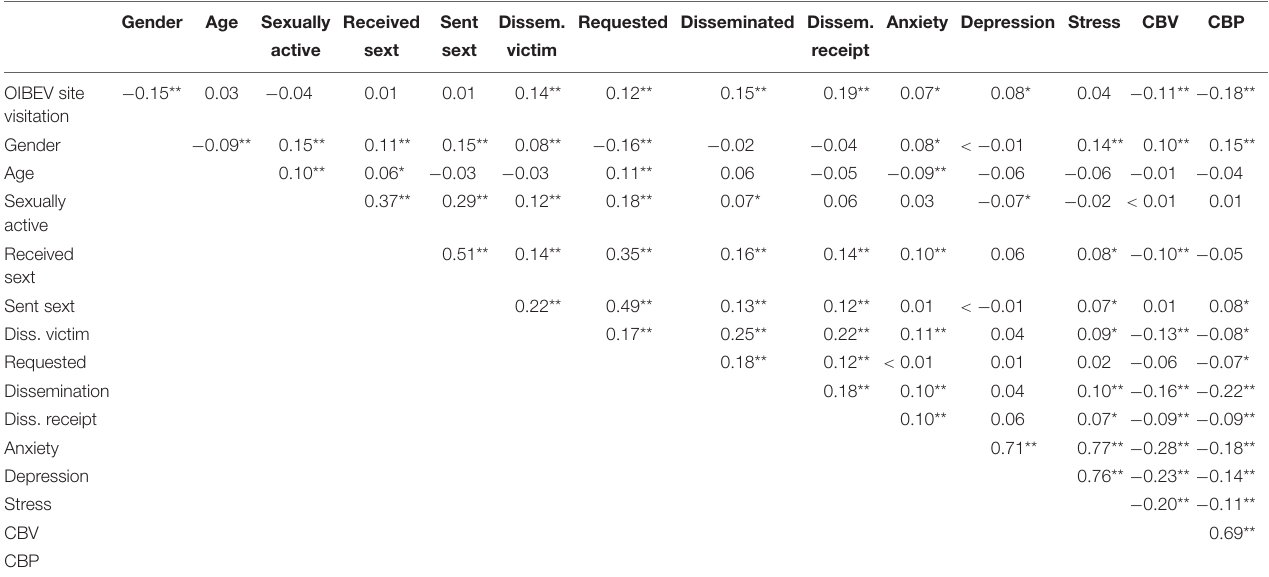
TABLE 2 | Point-biserial Correlations between OIBEV site visitation, online behaviors and mental health: full